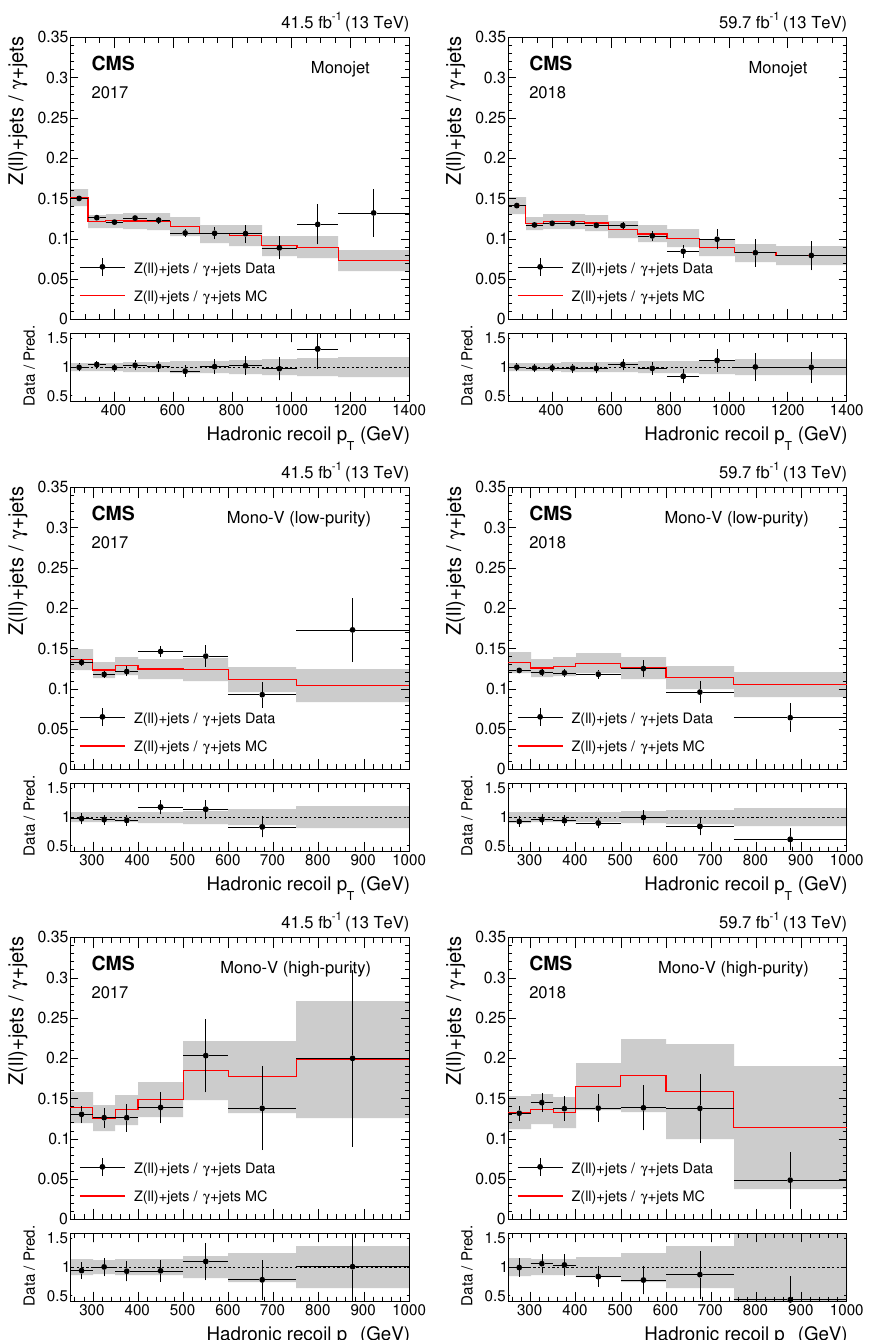
Figure 3 . Ratio of the dilepton to photon control region yields predicted using simulation (red solid line), and observed in data (black points). The gray band represents the total uncertainty in the ratio. In the lower panels, the ratio of data over prediction is shown. From upper to lower, the rows show the monojet, low-purity, and high-purity mono-V categories, while the left (right) column represents the 2017 (2018) data